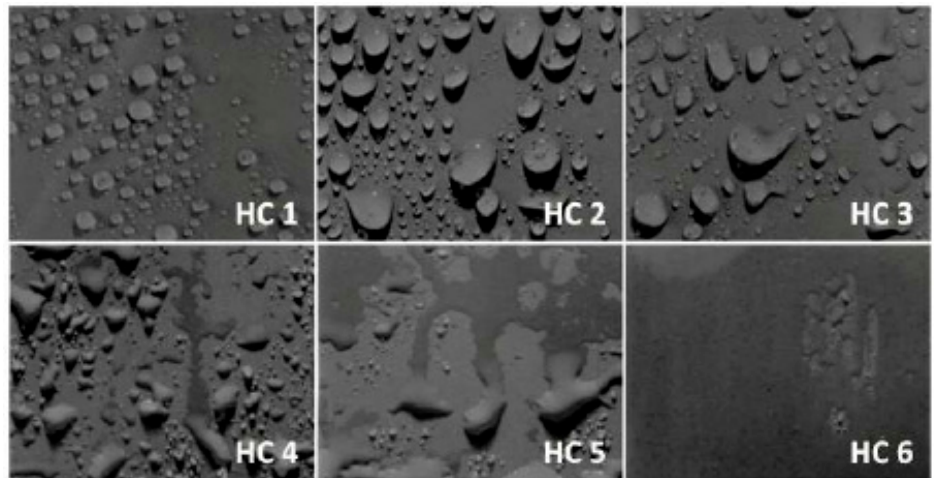
Figure 2. Hydrophobicity class Swedish transmission research institute (STRI) guide.